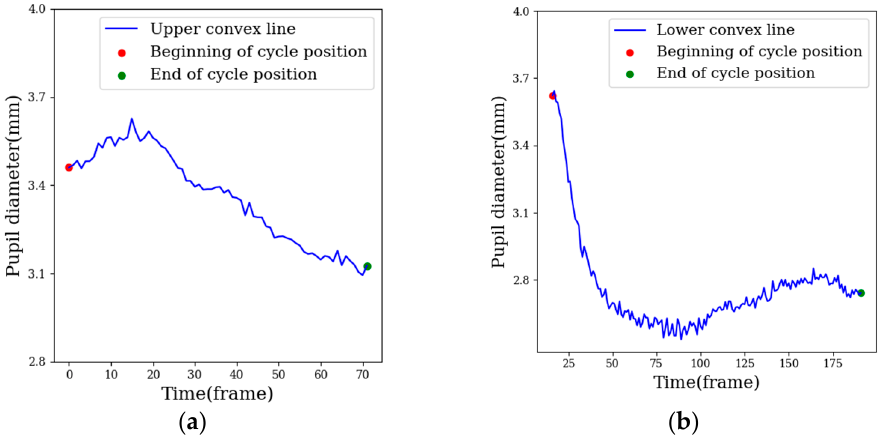
Figure 3. Cycle curve, ( a ) upper convex line, ( b ) lower convex line.